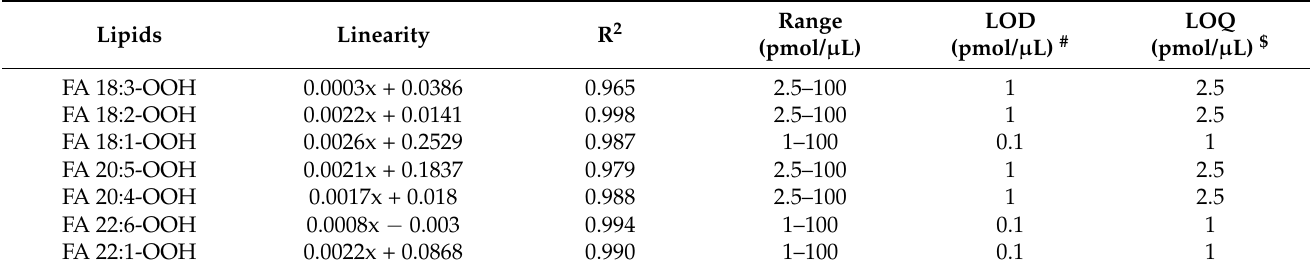
Table 2. Determination of linearity, LOD, and LOQ of FAOOH standards ( # LOD: limit of detection, $ LOQ: limit of quantification).